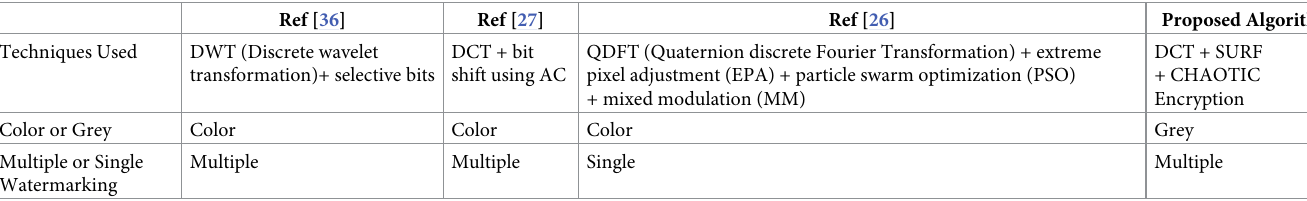
Table 6. Features comparison of the proposed algorithm with other